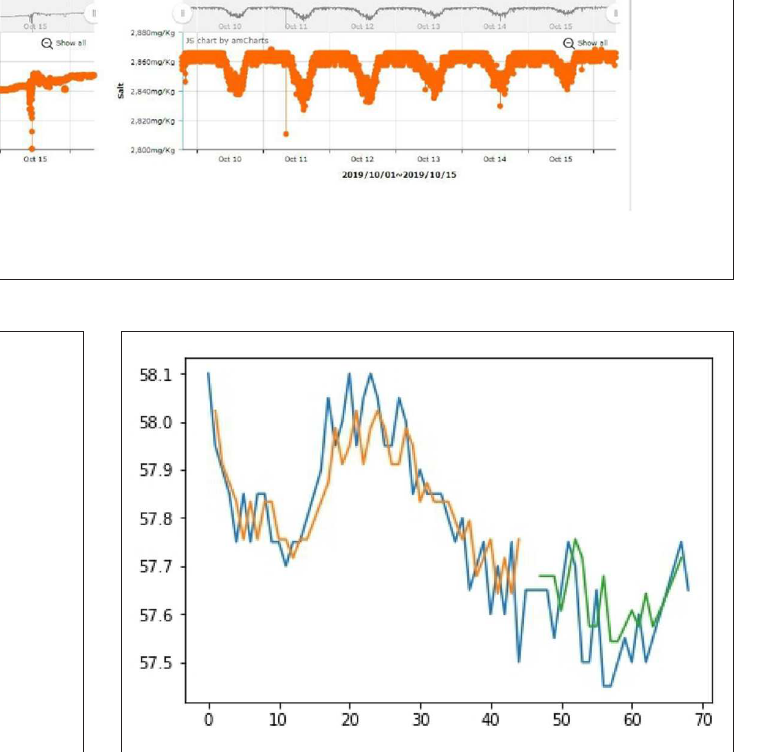
FIGURE 8 | Prediction result of humidity.